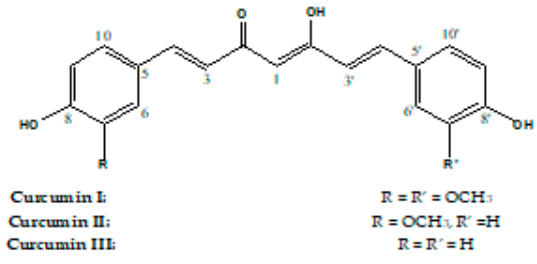
Figure 1. Structures of Curcumins I–III.